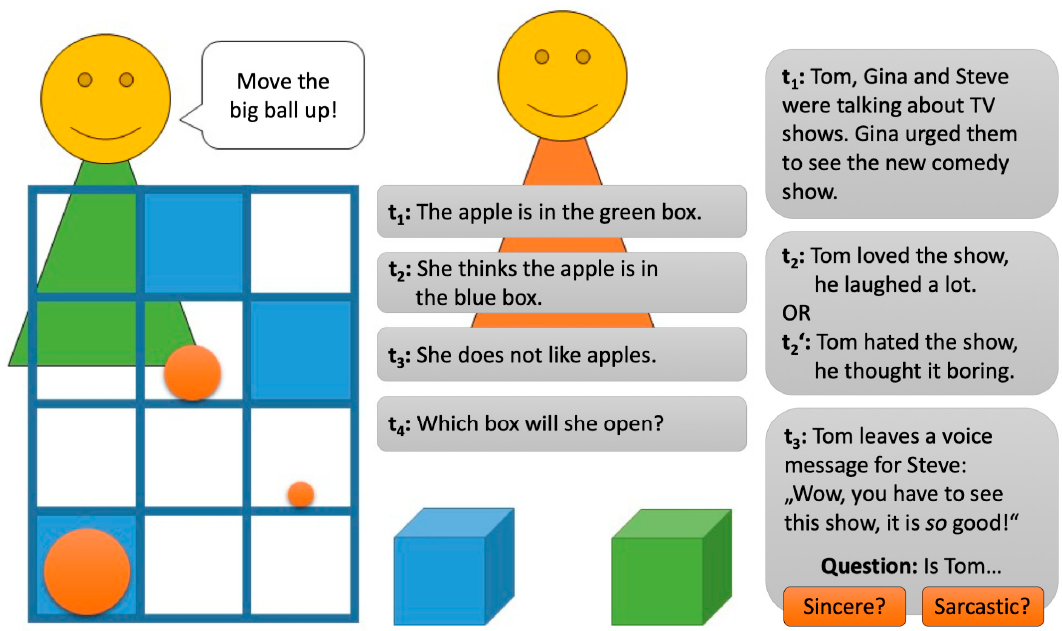
Figure 2. Standard perspective taking tasks. From left to right: the director’s task, belief–desire continuity test, and adapted anchor and adjustment paradigm.